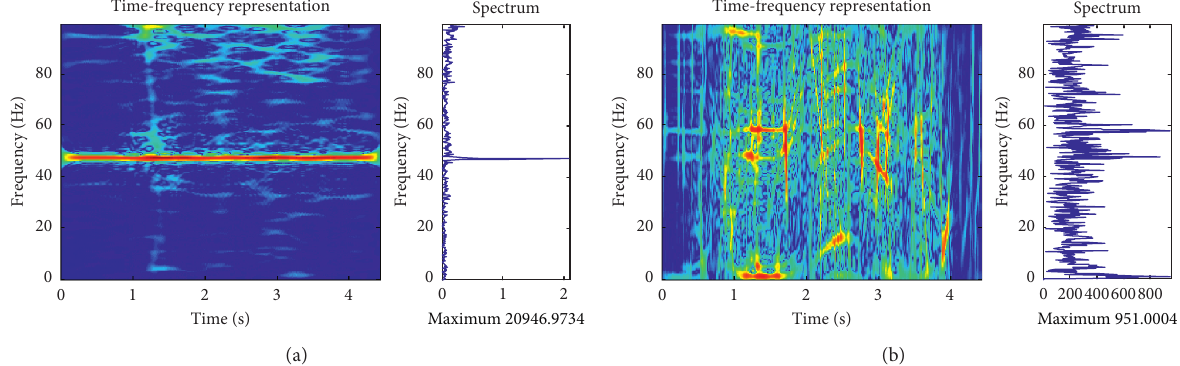
Figure 11: Time-frequency distribution of the rope vibration under 46.7 ° Hz longitudinal excitation. (a) Transverse. (b)